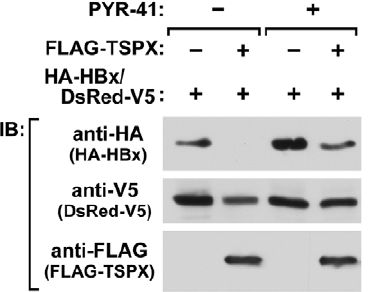
Figure 3. TSPX mediates HBx degradation through ubiquitin- proteasome pathway. Ubiquitin-activating enzyme inhibitor PYR-41 inhibits TSPX-mediated enhancement of HBx-degradation. HA-HBx expression vector (0.2 m g/well) and DsRed-V5 expression vector (0.1 m g/well) were co-transfected into 293T cells with FLAG-TSPX[ D Pro] (0.05 m g/well). Twenty-four hours after transfection, cells were treated with either vehicle (DMSO) or 50 m M PYR-41 for additional 24 h. Cell lysates were analyzed by Western blot using anti-HA, anti-V5 and anti- FLAG antibodies. Treatment with PYR-41 significantly increased the HA- HBx even in the presence of